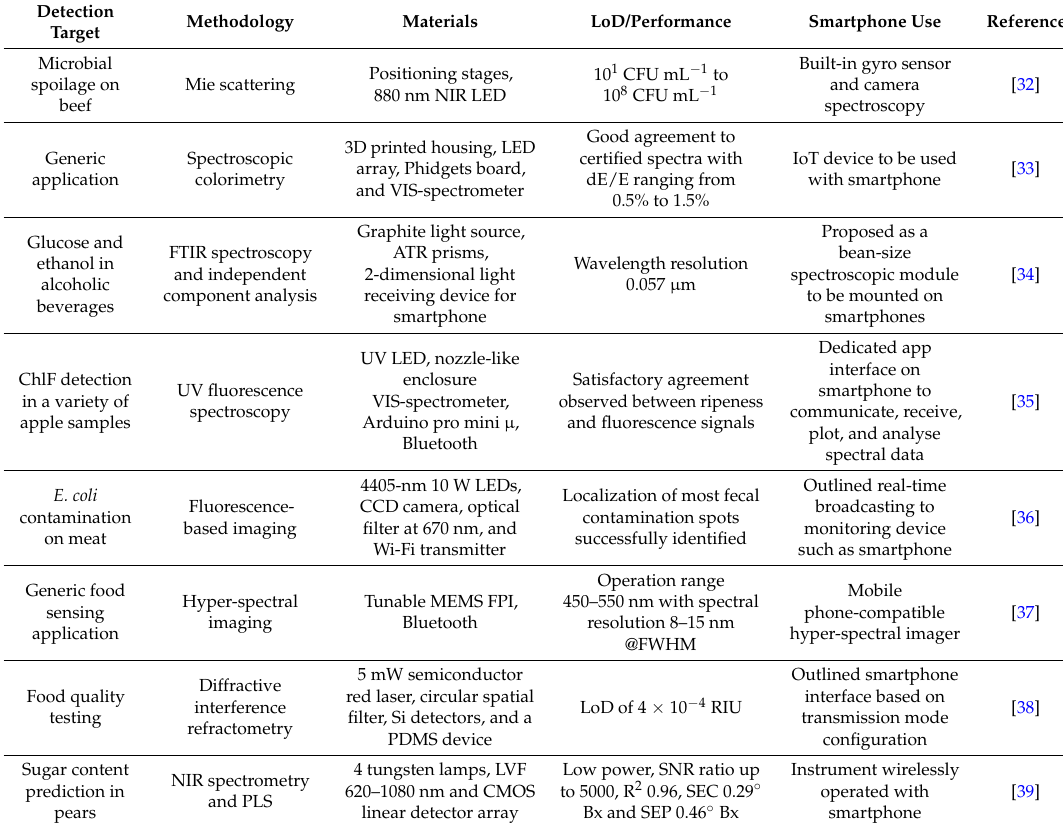
Table 2. Summary of recent smartphone spectroscopy